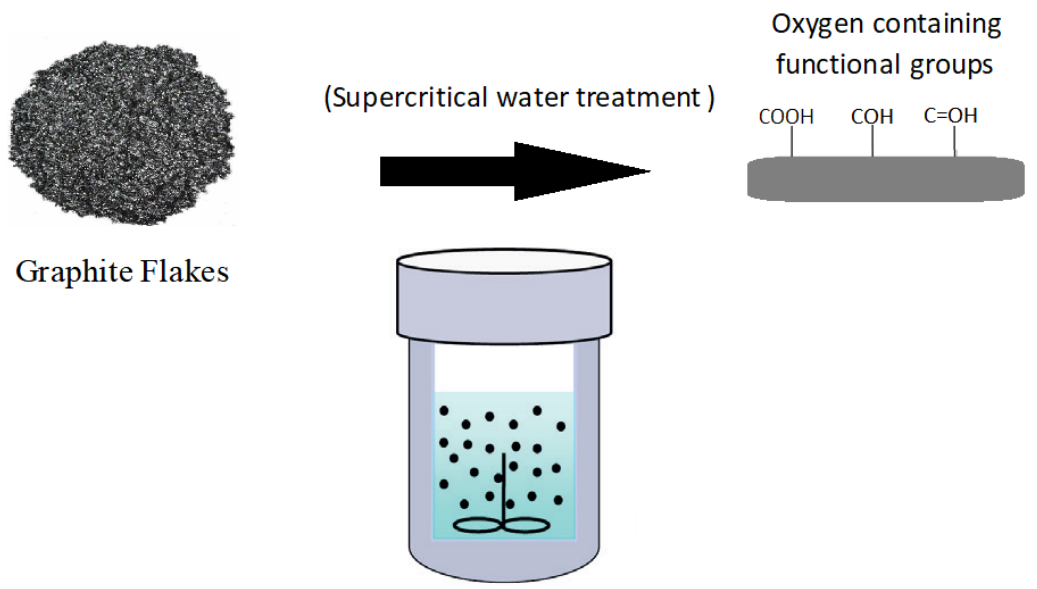
Figure 1. Supercritical Water Treatment of Graphite Flakes.